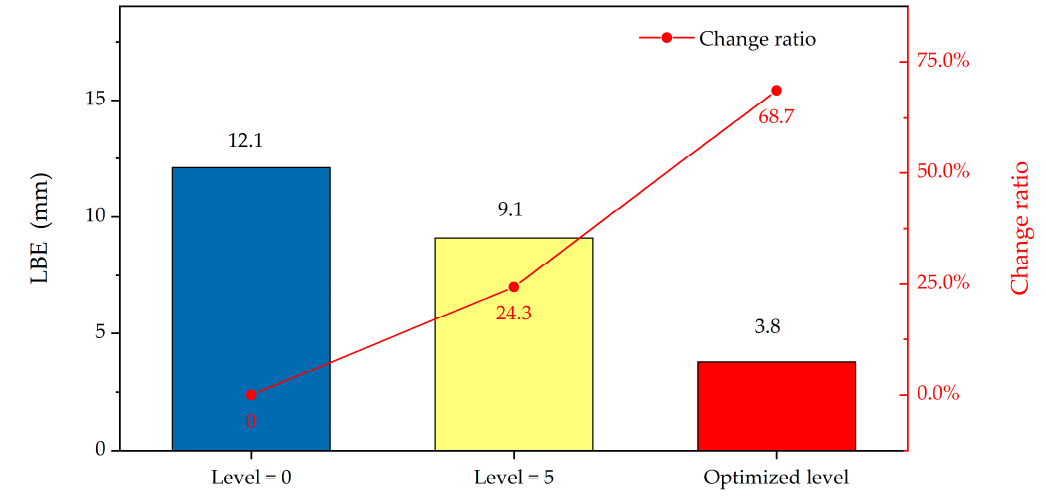
Figure 10. Comparison of lateral breakthrough error (LBE) for di ff erent filtering